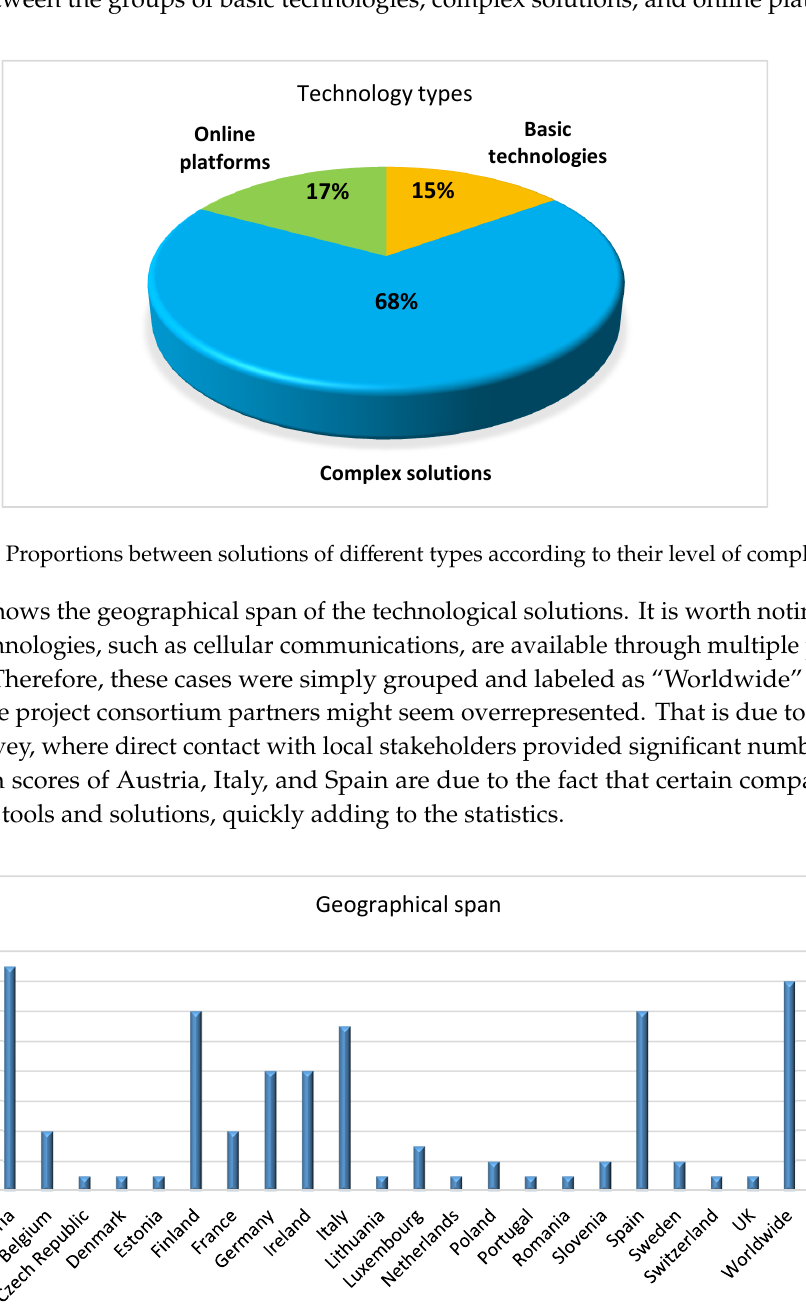
Figure 3. Number of identified technologies, tools, and services per country.